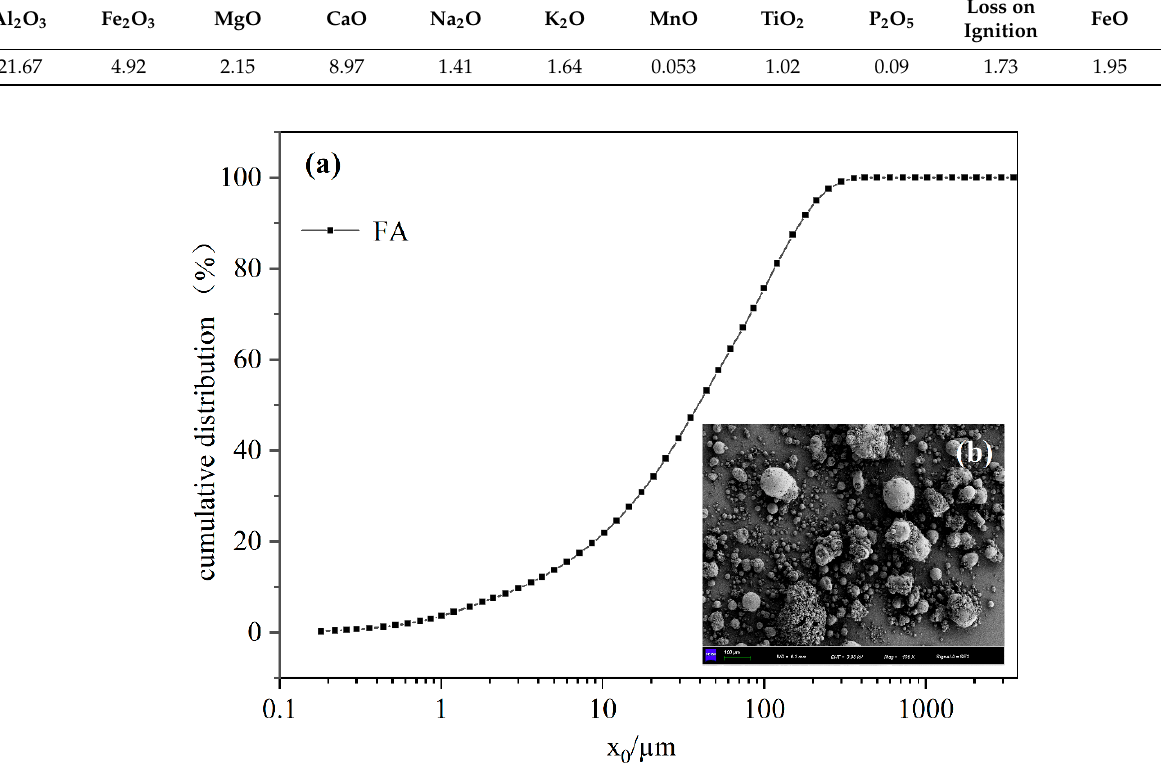
Figure 1. Particle size distribution curve ( a ) and SEM image ( b ) of